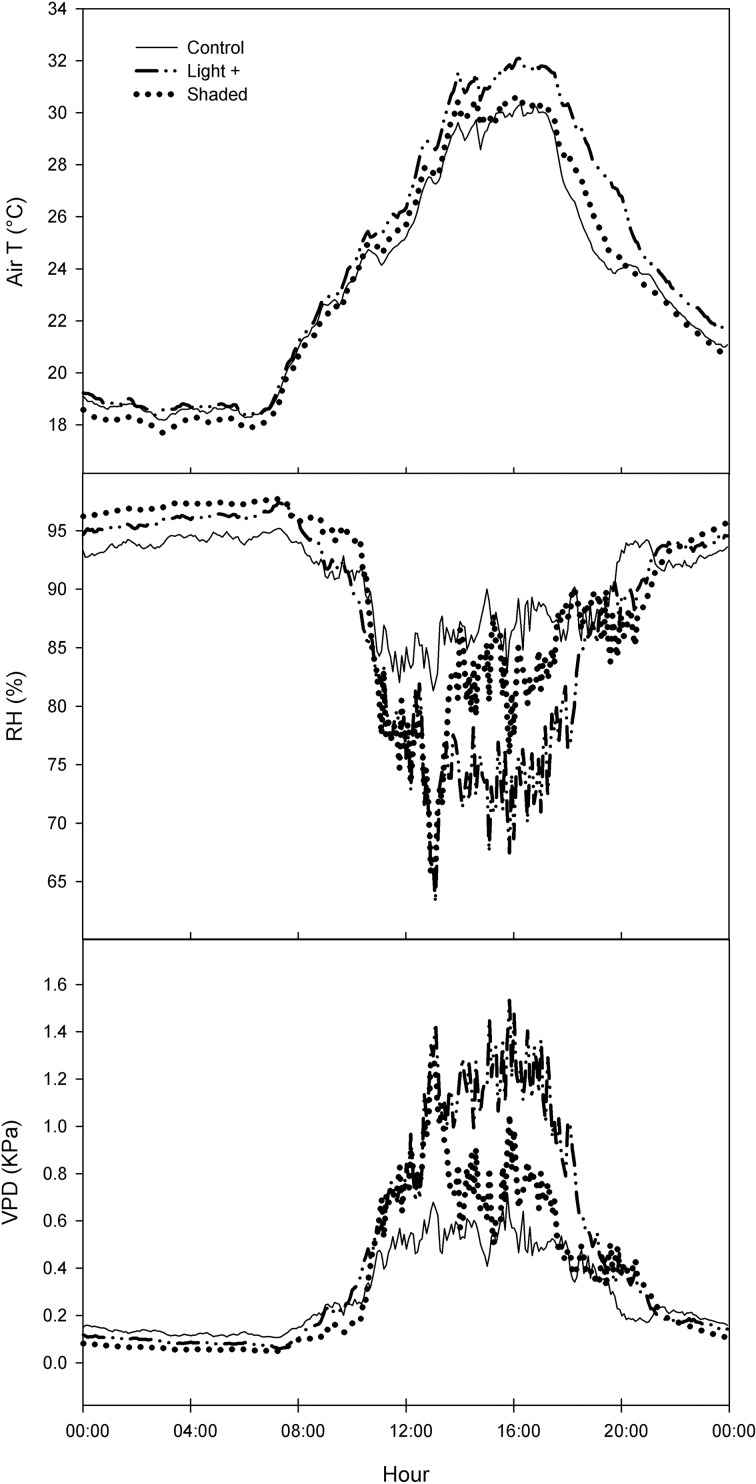
Daily trend of air temperature (T), relative humidity (RH), and air vapor pressure deficit (VPD) in Control, Light+, and Shaded treatments. Curves are the mean of three consecutive days (DOY 174–176).